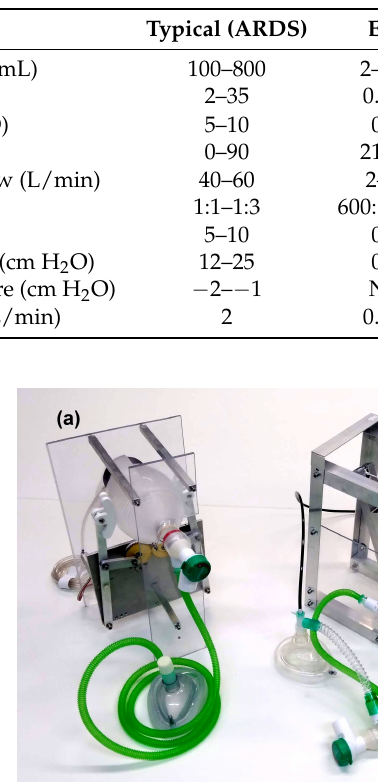
Table 2. Comparison of main characteristics of a state-of-the-art mechanical ventilator (Dräger Evita) [17], the CLAPER and the eARM systems. a Externally controllable by voltage supply, b digital control tested in the range of 4–8. c Externally operated.